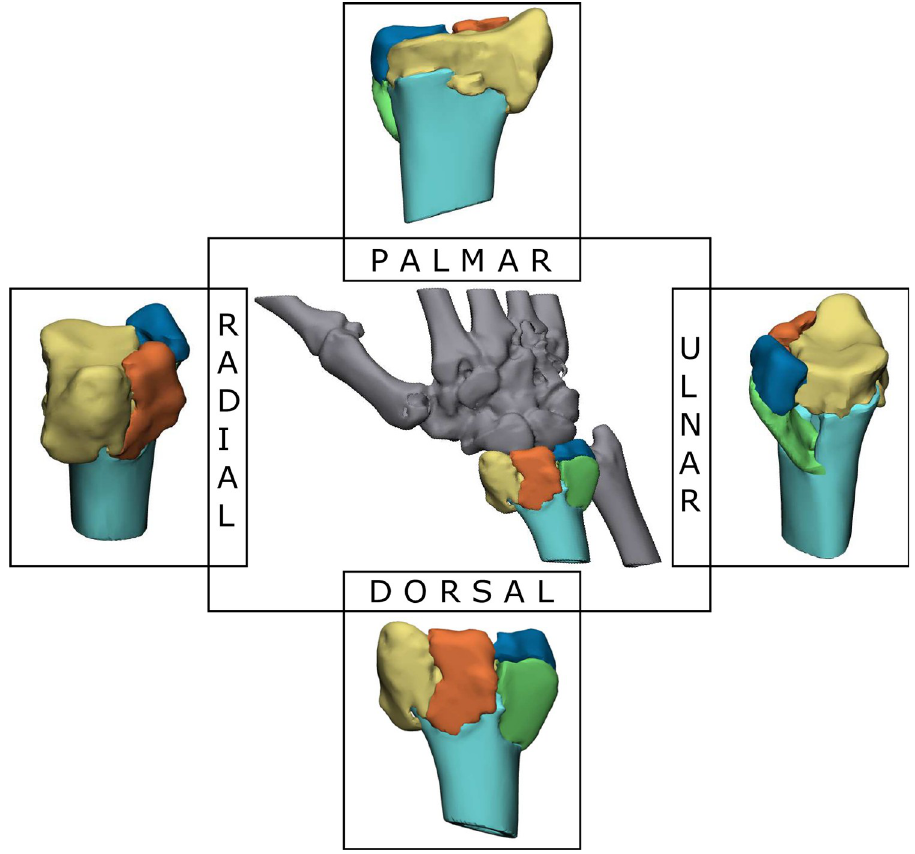
Fig 1. 3D fracture model of the distal radius of patient 1. The central image displays a dorsal view of the fractured radius with the hand and ulna in grey for orientation. The radial shaft is displayed in light blue. The randomly assigned yellow, orange, and dark blue colors indicate intra-articular fragments. In this specific case the green fragment is considered